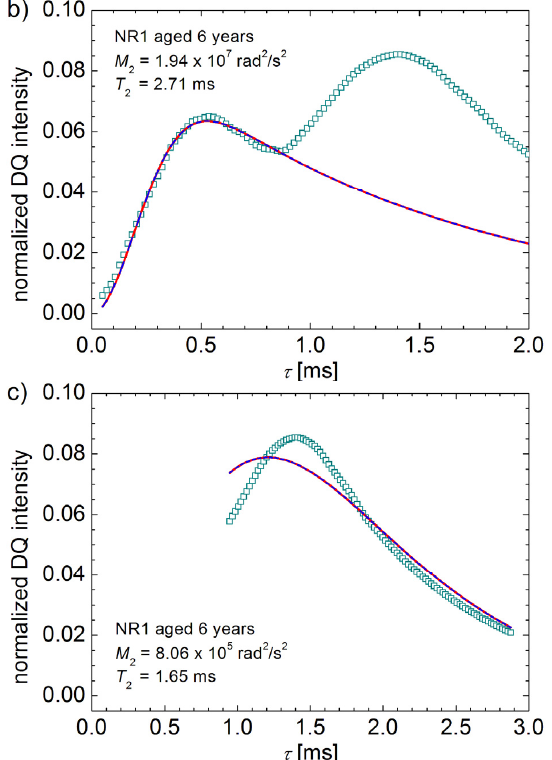
Figure 2. ( a ) The best fit of DQ build-up curve for sample NR1 aged six years using Equation (4). The best fit of the first peak ( b ) and the second peak ( c ) using Equation (2).